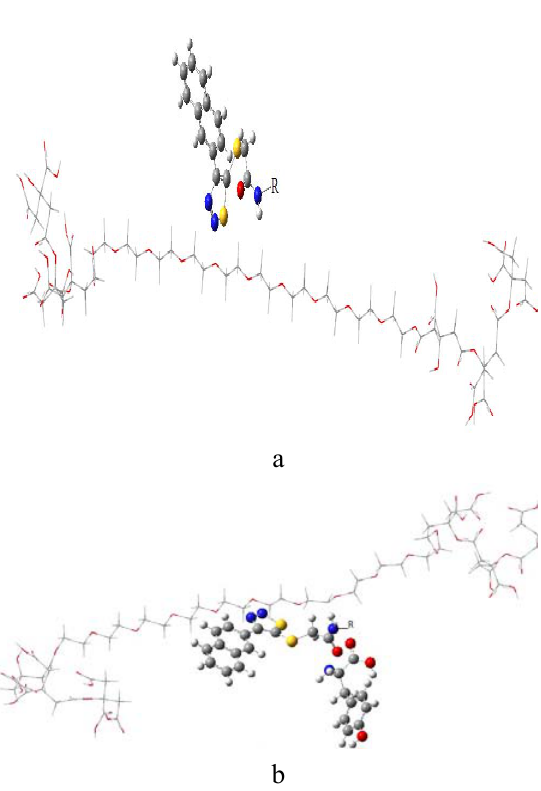
Fig. 1. Interaction of a) TTA derivatives